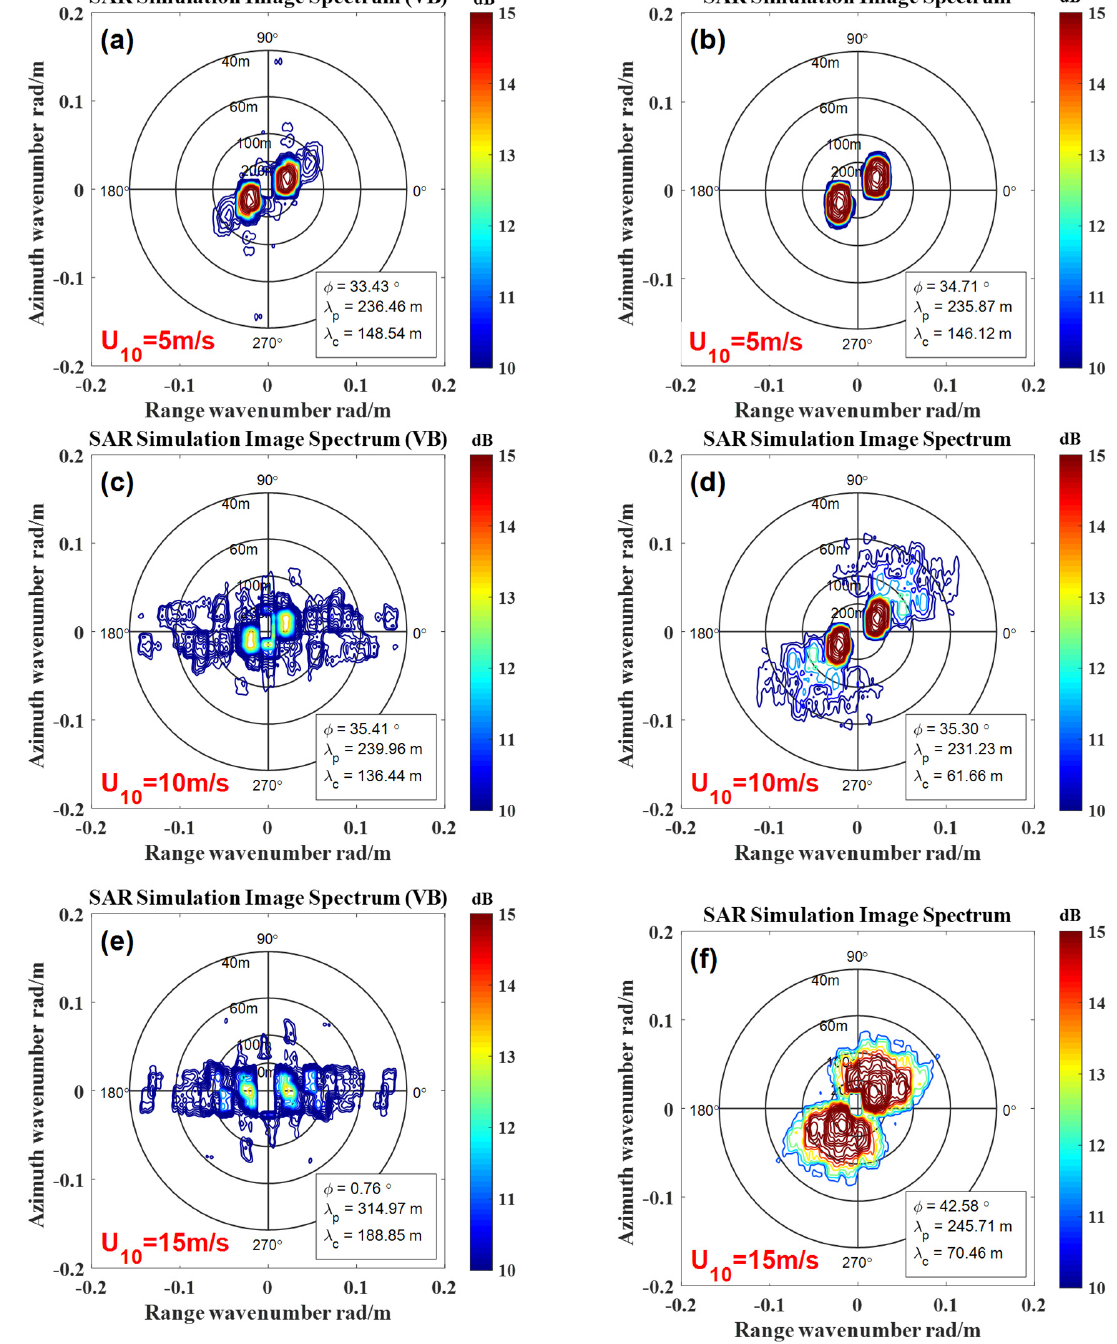
Figure 9. The SAR image spectra corresponding to the SAR images in the Figure